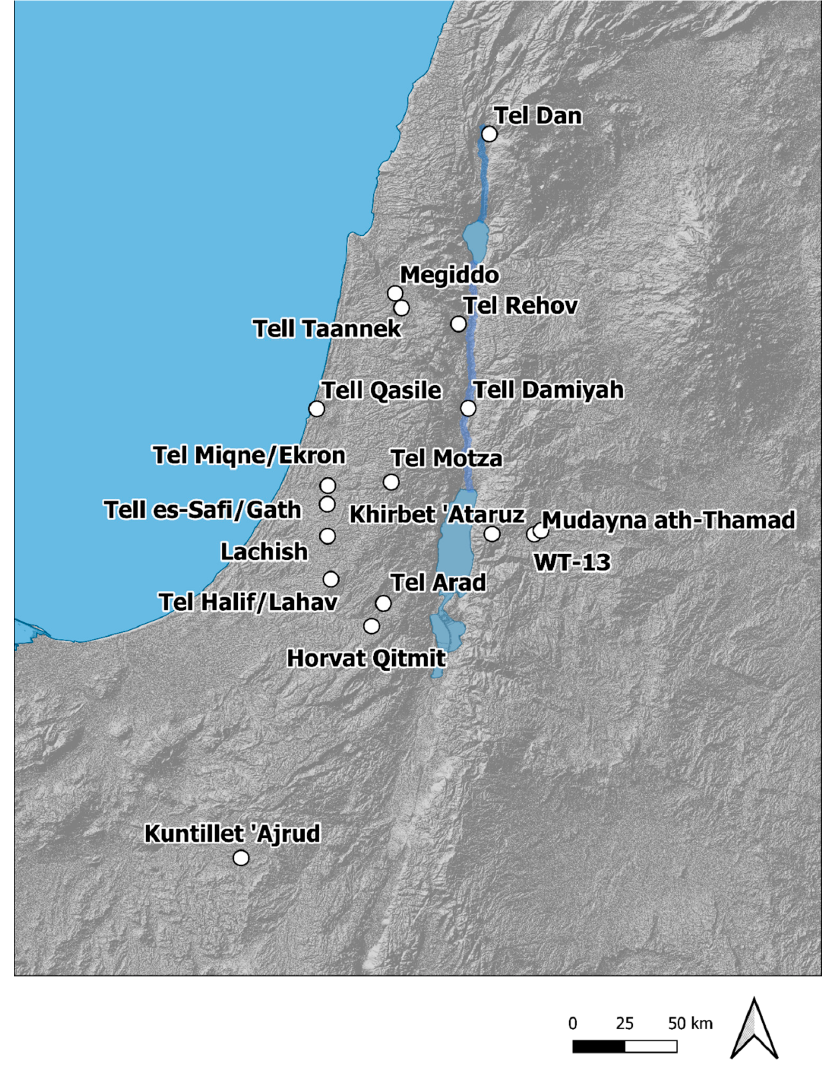
Figure 1. Sites mentioned in the text.